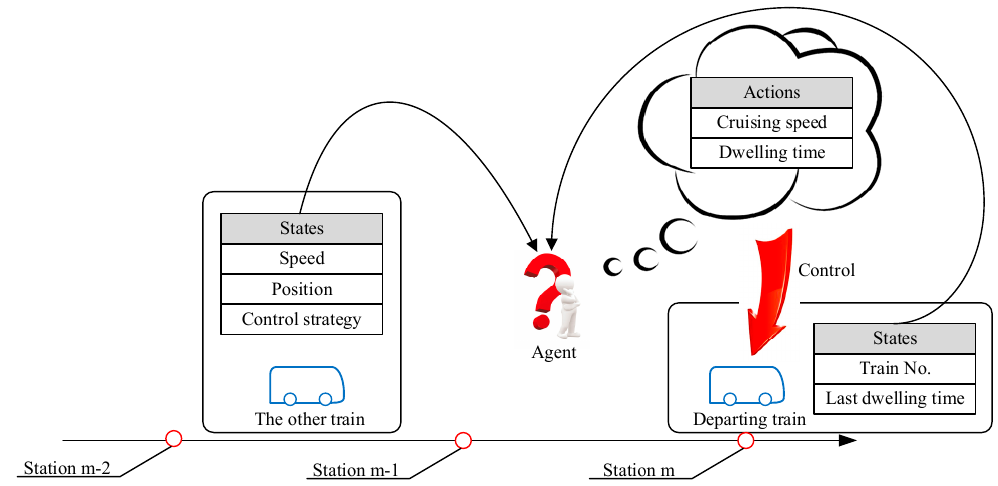
Figure 5. Sketch map of DDPG in the two-train network.